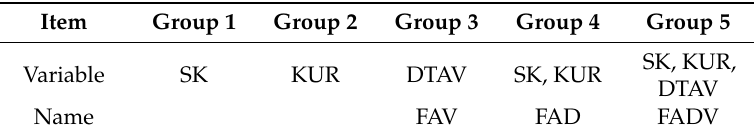
Table 4. Names of each classified